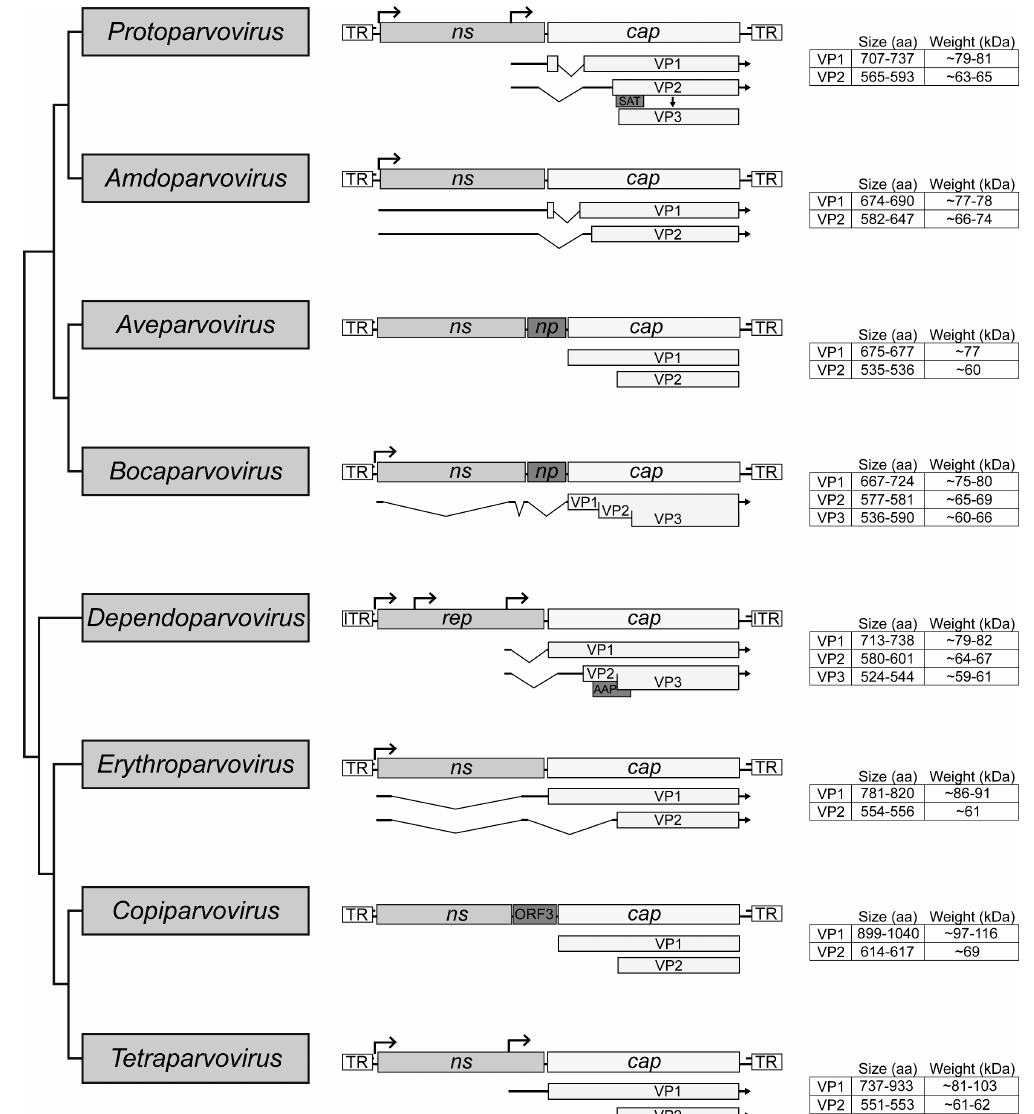
Figure 2. Cladogram of the subfamily Parvovirinae . The eight genera are shown. The general genome organization of each genus is shown in the middle with their ORF. The non-structural (NS) protein expressing genes ns or rep are simplified and only the ORF is shown. Below the cap ORF the transcripts for the expression of the individual VP are shown. On the right side the size and weight of the VPs are given. Note that the transcription profiles of the Aveparvovirus and Copiparvovirus genera have not been determined, and thus the sizes of the VPs are based on in silico